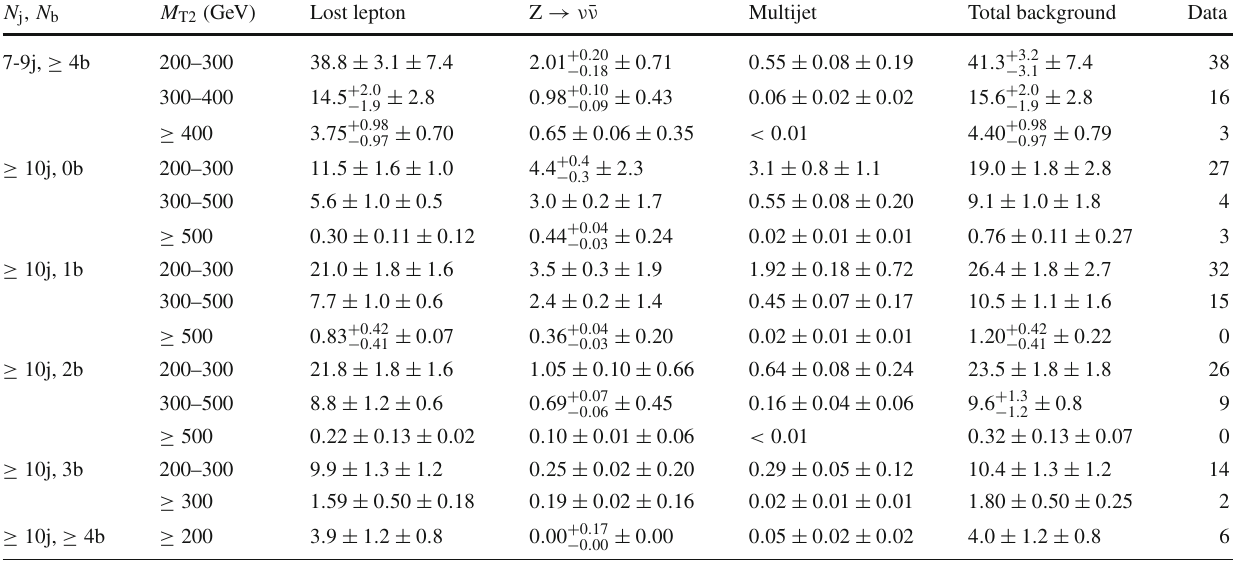
size of data control samples and Monte Carlo samples), and the second is